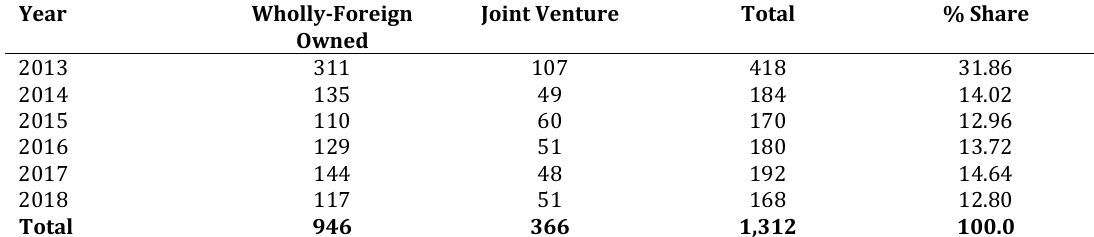
Table 2: breakdown of the total number of FDI registered projects in from 2013 to 2018